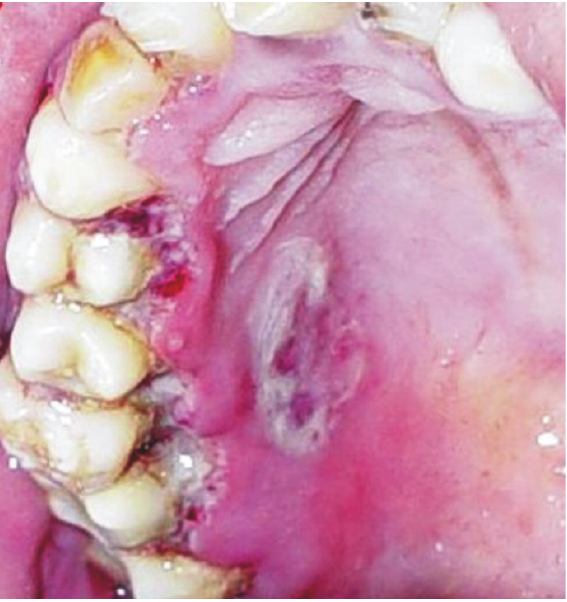
Figure 6 - Acute necrotizing ulcerative gingivitis also affecting the hard palate Figure 8 - Cutaneous necrosis secondary to cancrum oris